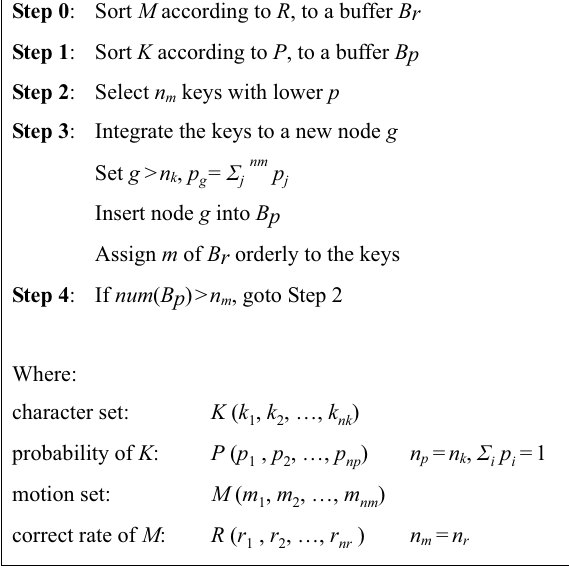
Algorithm 1 for the modified Huffman coding algorithm.